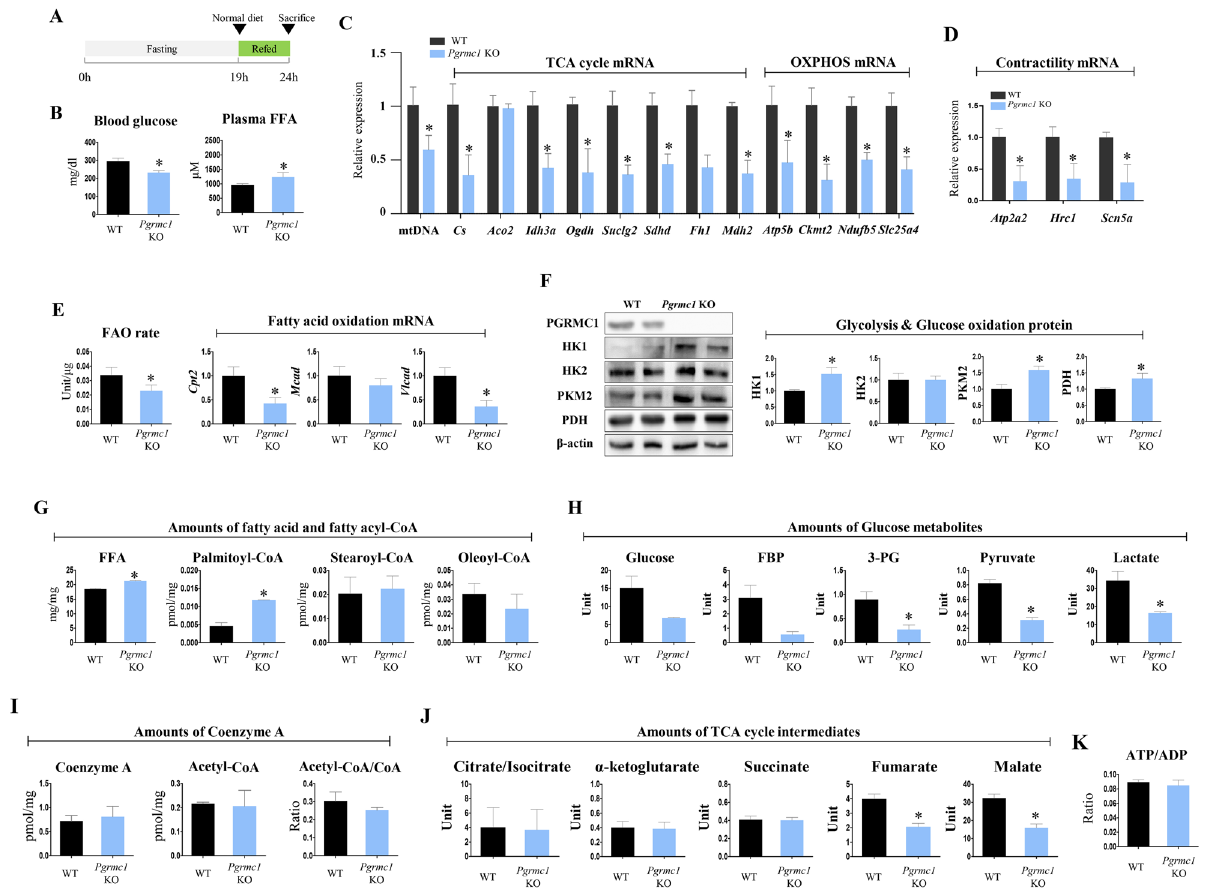
Figure 2. Pgrmc1 KO mice show high levels of cardiac FFA and paltimoyl-CoA, but low levels of cardiac glucose metabolites and TCA cycle intermediates in refed state. ( A ) Schematic diagram which presents experimental schedule for refed state. ( B ) Levels of blood glucose (mg/dl) and plasma FFA (µM) in refed WT and Pgrmc1 KO mice. ( C ) Expression of mitochondrial DNA (mtDNA) in hearts of refed WT and Pgrmc1 KO mice. Nuclear DNA was used for an internal control. mRNA expression of TCA cycle and OXPHOS in hearts of refed WT and Pgrmc1 KO mice. Rplp0 was used for an internal control. ( D ) mRNA expression of contractility markers in hearts of refed WT and Pgrmc1 KO mice. Rplp0 was used for an internal control. ( E ) Fatty acid oxidation activity in hearts of refed WT and Pgrmc1 KO mice. mRNA expression of fatty acid oxidation genes in hearts of refed WT and Pgrmc1 KO mice. Rplp0 was used for an internal control. ( F ) Western blot analysis and quantification of glycolysis and glucose oxidation genes in hearts of refed WT and Pgrmc1 KO mice. β-Actin was used for an internal control. ( G ) Cardiac FFA level (µM) and fatty acyl-CoA levels (pmol/mg) in refed WT and Pgrmc1 KO mice. ( H ) Levels of glucose metabolites (unit) in refed WT and Pgrmc1 KO mice. ( I ) Levels of coenzyme A (CoA) and acetyl-CoA in refed WT and Pgrmc1 KO mice. ( J ) Levels of TCA cycle intermediates in refed WT and Pgrmc1 KO mice. ( K ) Ratio of ATP per ADP in refed WT and Pgrmc1 KO mice. Values represent means ± SD. *p < 0.05. Student’s t test was performed. Total numbers of mice used for experiment were 8 (refed WT), and 6 (refed Pgrmc1